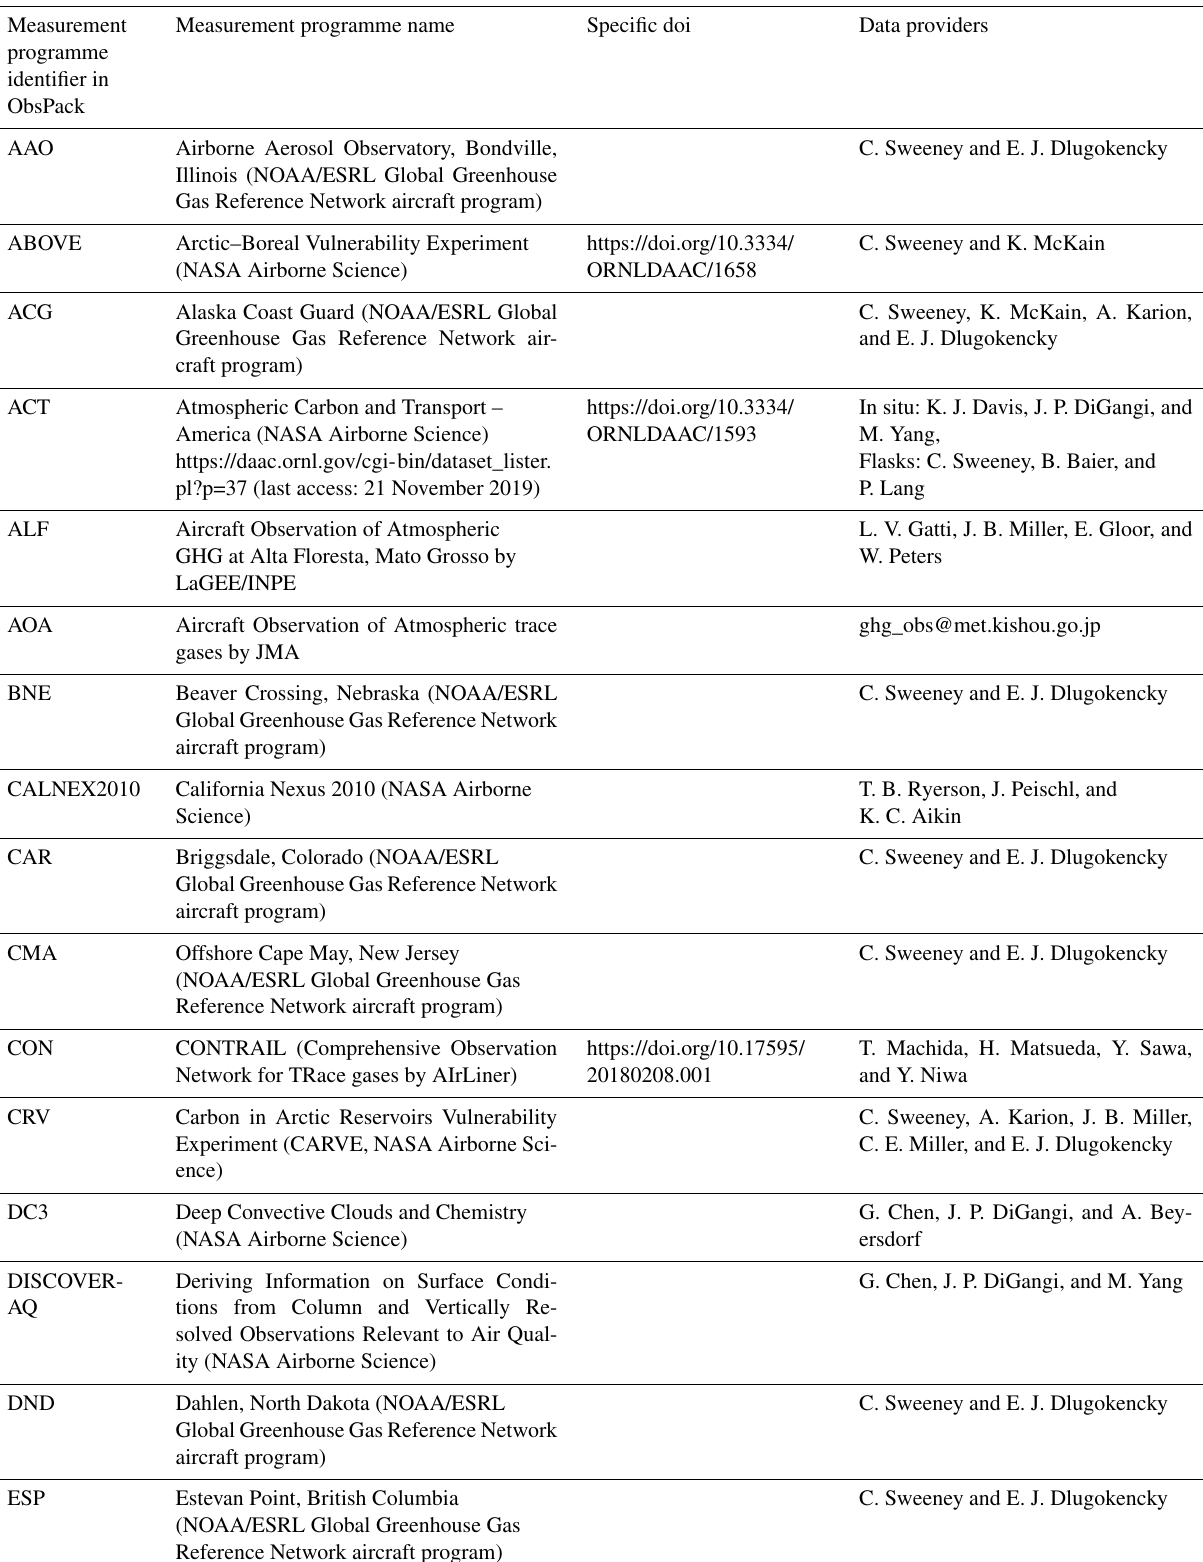
Table 1. Aircraft measurement programmes used here. Note that the ALF, PAN, RBA-B, SAN and TEF programmes are gathered under the identifier “INPE” (for Instituto Nacional de Pesquisas Espaciais) in Fig. 8.